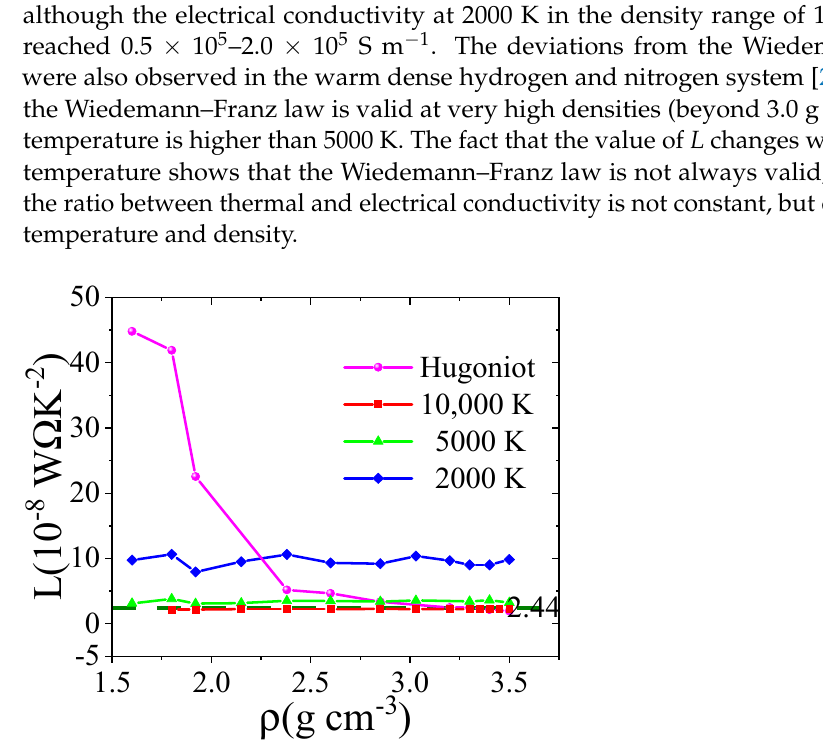
Figure 10. Lorenz number L of warm dense NO along isotherms and the principal Hugoniot using PBE functional. The olive dash line corresponds to L 0 = 2.44 × 10 − 8 W Ω K − 2 .